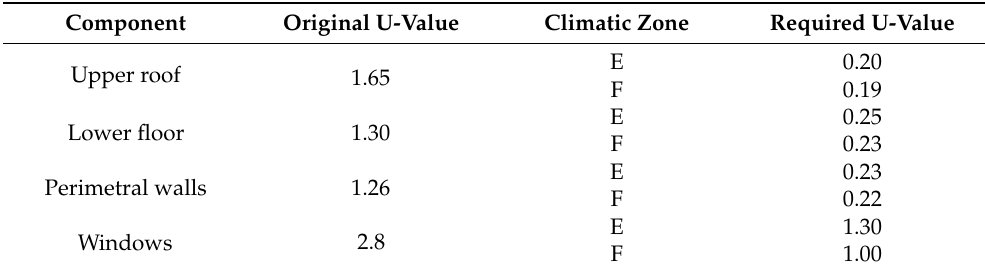
Table 1. Thermal transmittance (U-value, Wm − 2 K − 1 ) of the benchmark buildings of this study, based on the TABULA/EPISCOPE databases [30,31], along with the current legislative requirements [33] considered for the simulation of fully refurbished